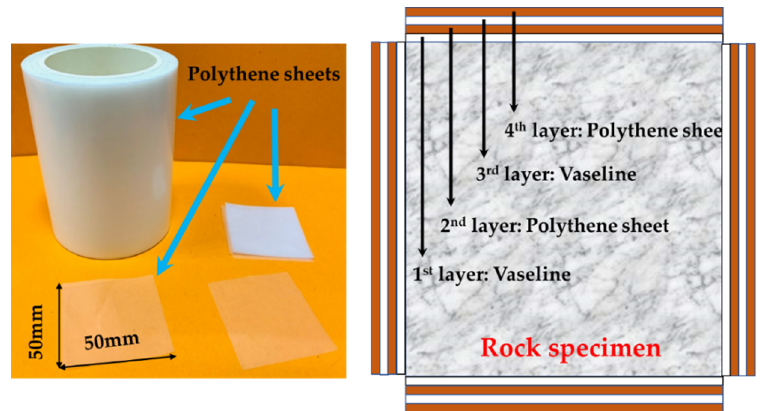
Figure 4. Anti-friction measures.